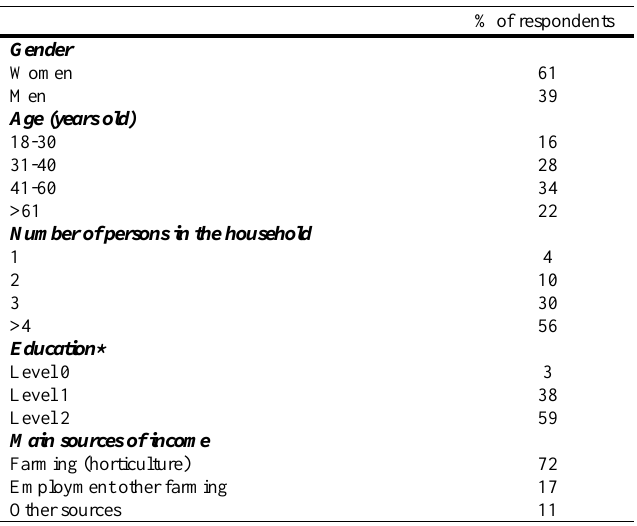
Table 1. Respondent profiles.